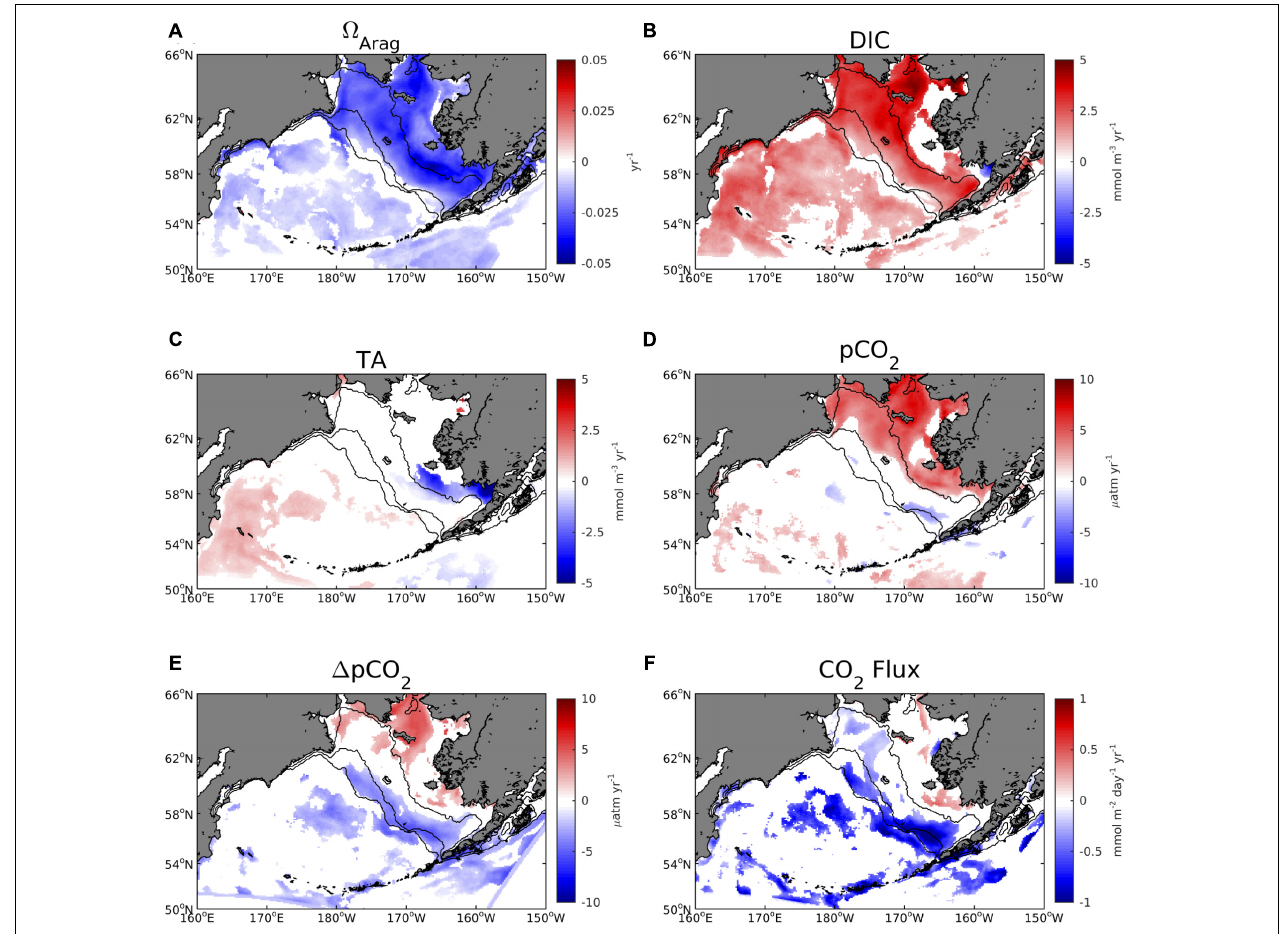
FIGURE 11 | Linear trends in annual average surface model (A) (cid:127) Arag , (B) DIC, (C) TA, (D) p CO 2 , (E) (cid:49) p CO 2 , and (F) air-sea CO 2 flux. Linear trends are calculated using the 2003–2012 timeframe. Only trend values that are significant at the 95% confidence level are